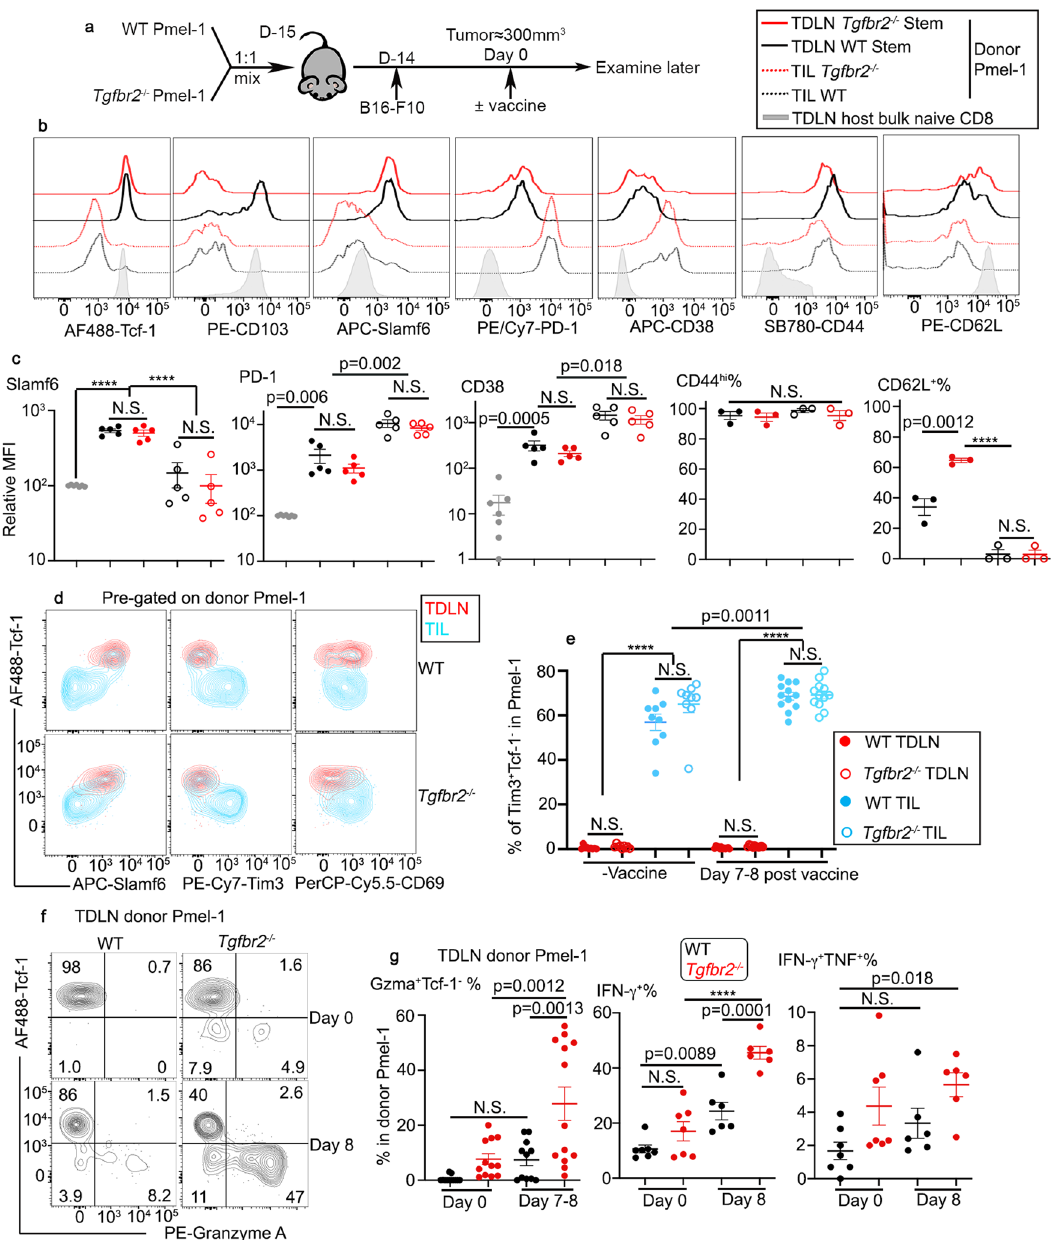
Fig. 6 | Tcf-1 + Pmel-1 T cells in TDLN are antigen-experienced T cells and dif- ferentiate into Tcf-1 - effectors in response to tumor vaccine. a Experimental design. b – d In the absence of tumor vaccine. e – g Side-by-side comparison of unvaccinatedvsd7 – 8postvaccine. b Representativehistogramsofpre-gatedTcf-1 + Pmel-1 T cells isolated from TDLN, total TIL Pmel-1 T cells and host-derived bulk naiveCD8areshown.In b ,blackline,WTandredline, Tgfbr2 − / −